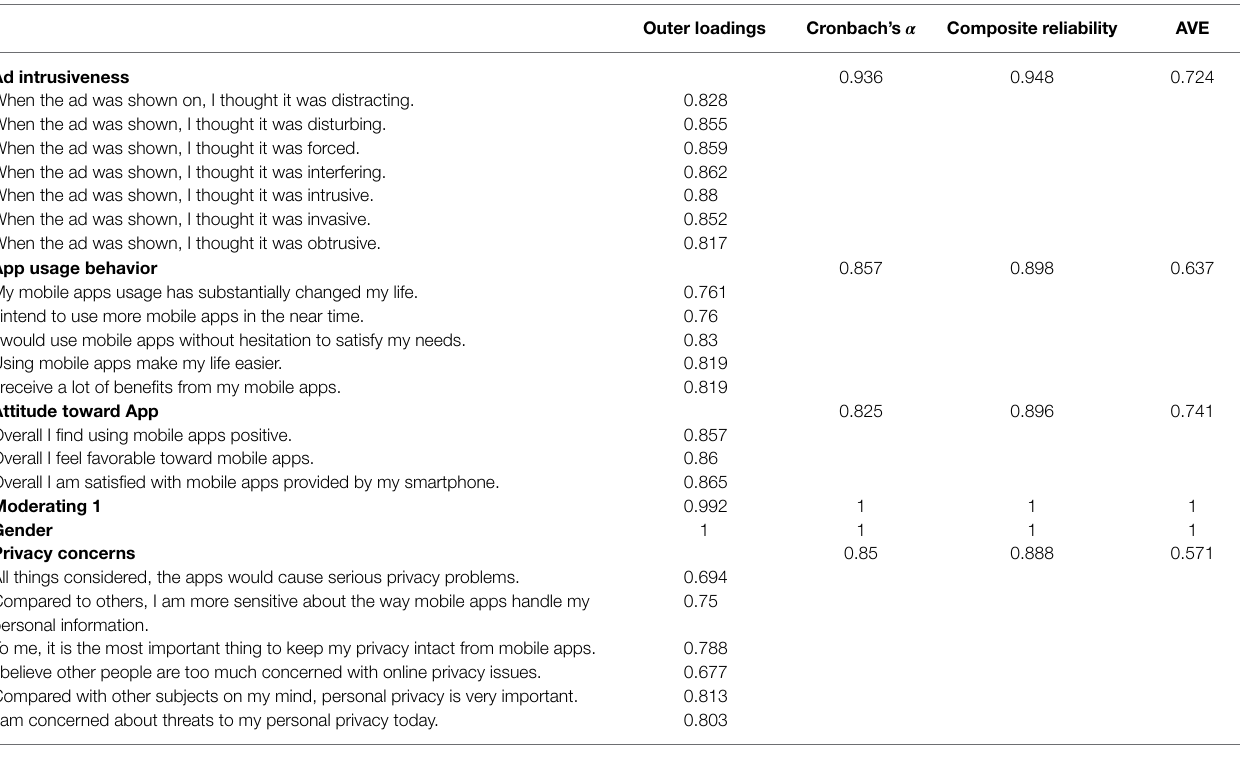
TABLE 2 | Convergent validity.